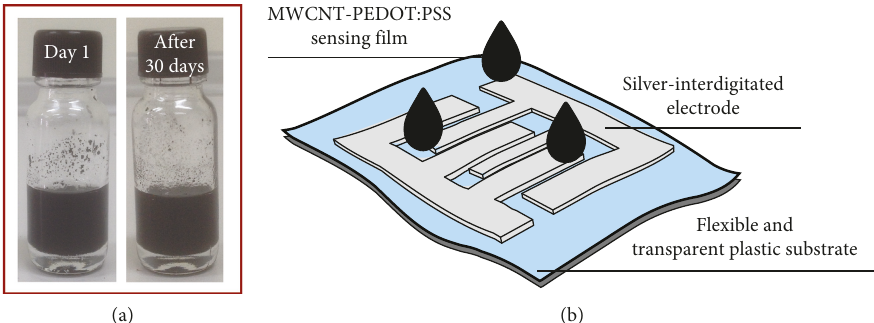
Figure 7: (a) Photographs of purified MWCNTs immersed in DI water after storage in 1day and 30days. (b) Schematic diagram of a fabricated gas sensor.